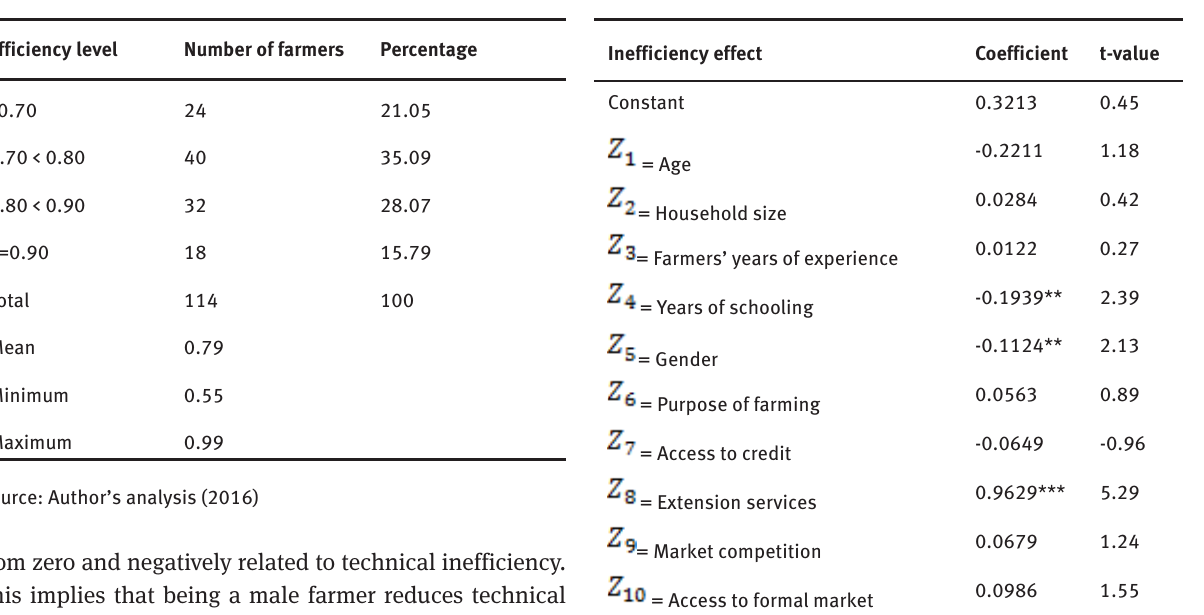
Table 6: Estimates of inefficiency effect